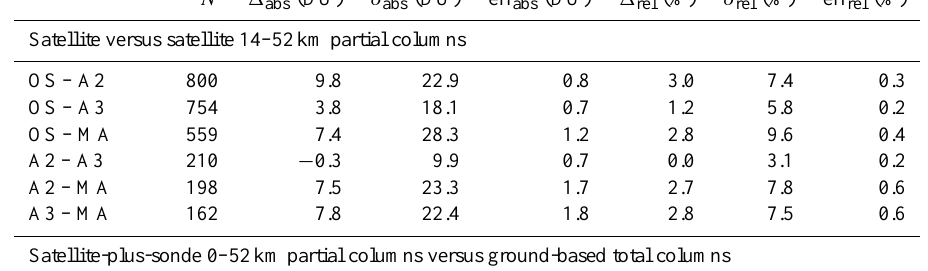
Table 3. Number of coincidences (N), mean absolute difference ( 1 abs ) and mean relative difference ( 1 rel ) between ozone measurements with respective standard deviation ( σ) and standard error (err). Instrument abbreviations are summarized in Table 1. N 1 abs